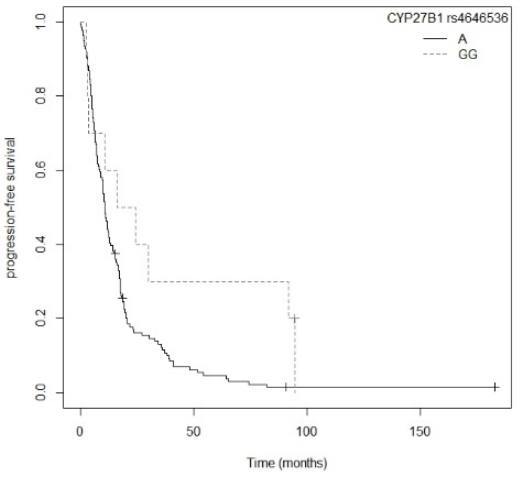
Figure 8. Kaplan–Meier plot of progression-free survival curves with the A allele of the CYP27B1 rs4646536 gene polymorphism in the non-resected NSCLC subgroup.